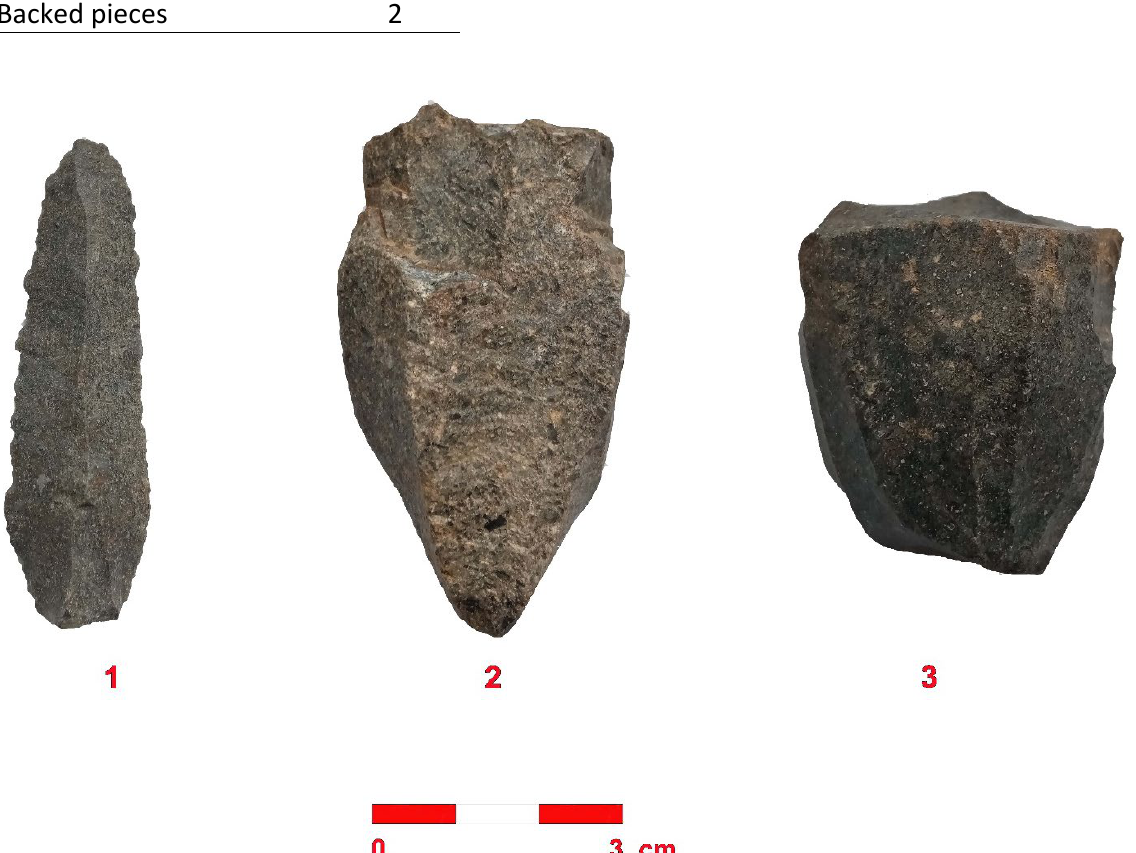
Figure 7. A point (1), a pyramidal shaped single platform blade core (2) and an opposite platform core